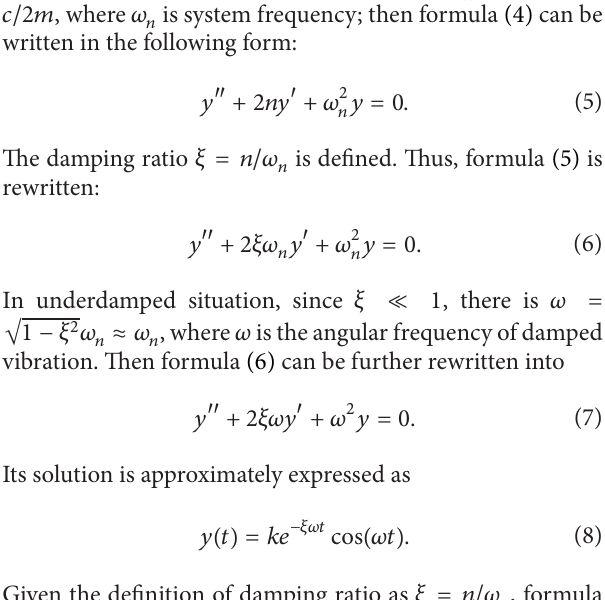
(a) Narrow band signals after NSP processing